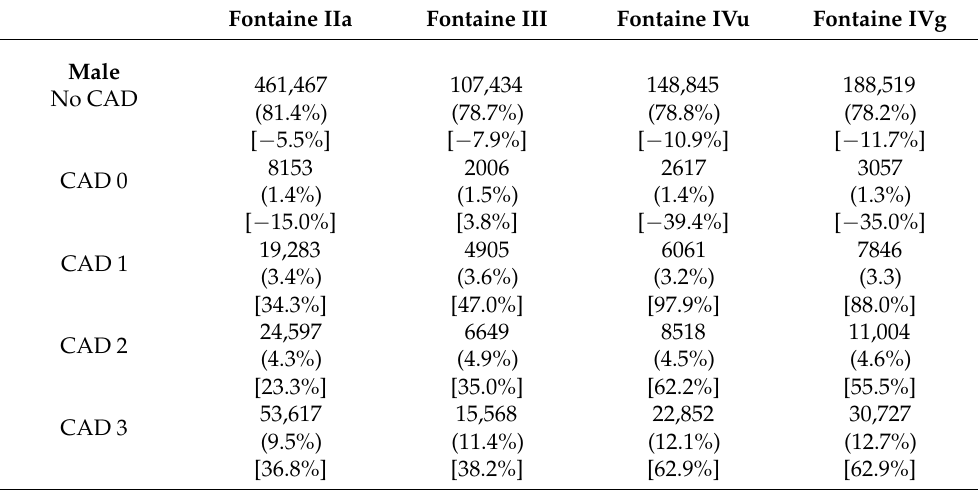
Table 2. Prevalence of patients hospitalized for peripheral artery disease with and without concomi- tant coronary artery